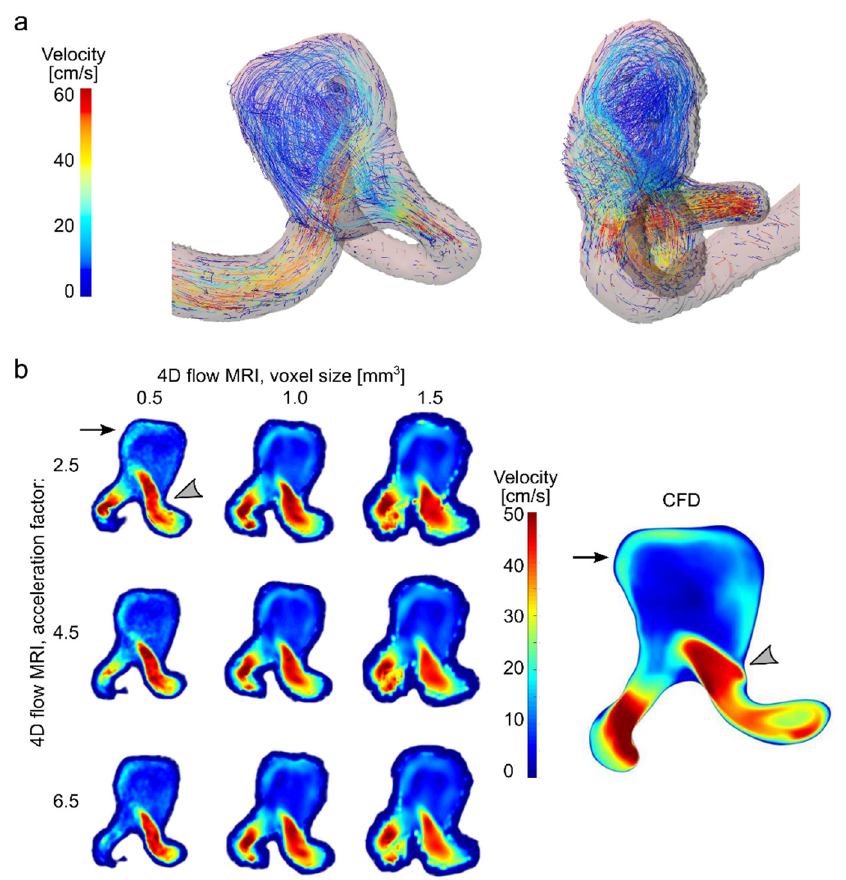
Figure 7. Effect of resolution and acceleration on velocity in an aneurysm flow model. ( a ) Visuali- zation of velocity streamlines of the flow in a patient-derived aneurysm model, obtained by 4D flow MRI with an isotropic voxel size of 1 mm 3 and a CS factor of 4.5. ( b ) Velocity field in patient-specific aneurysm model measured with 4D flow MRI and calculated with CFD. Note that a strong inflow jet from the parent artery into the aneurysm sac (gray asterisk) and residual flow on the opposite aneurysm wall (black arrows) were observed with all combinations of voxel sizes and CS factor of 4D flow MRI.